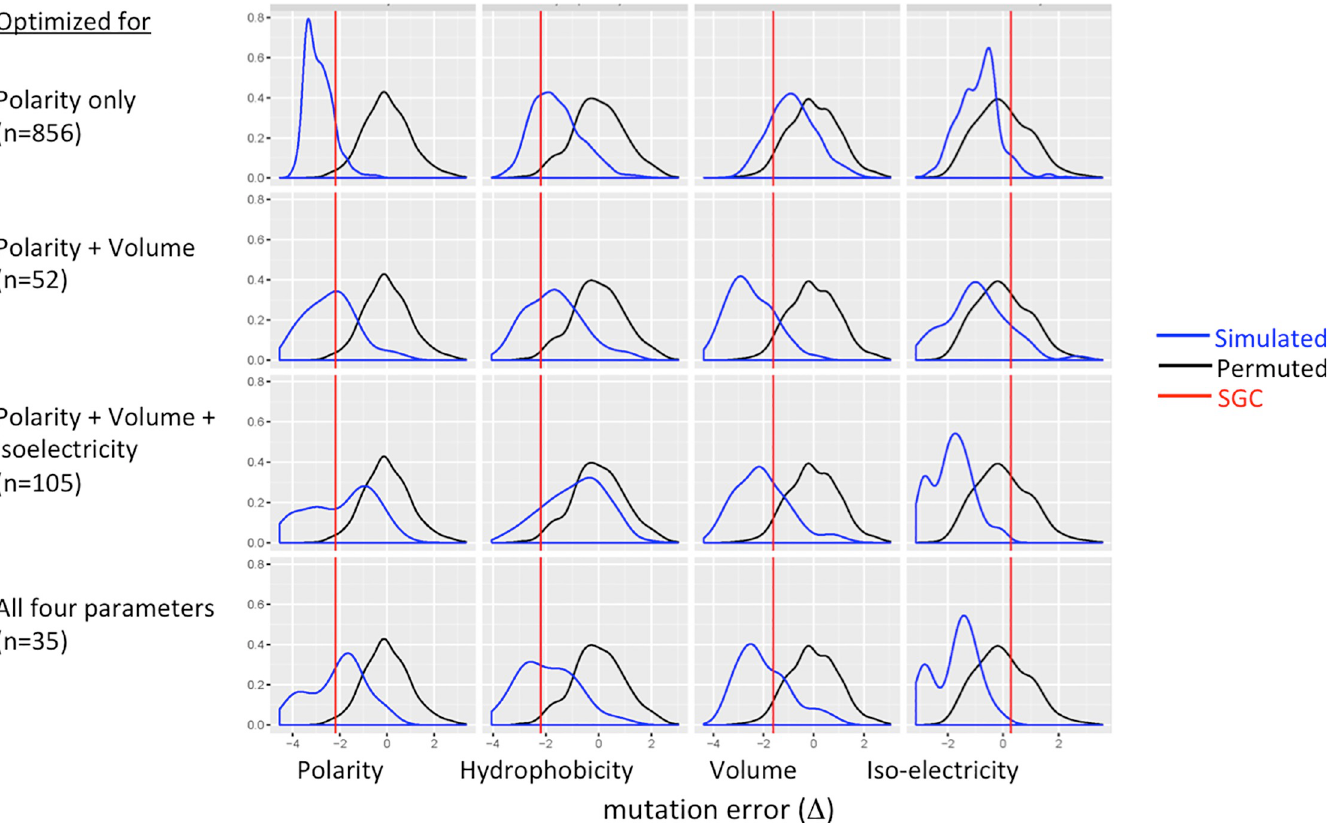
Fig 4. Hopfield network minimizes mutation errors. We constructed a 21-by-21 TSP and searched for the shortest paths traversing the 20 amino acids and the stop codon (21 “cities”) using Hopfield neural networks (see Methods). Distances between the “cities” were determined by either polarity alone ( top row ), or a combination of 2, 3, and all 4 parameters ( other rows ). Valid paths (number in parenthesis) were mapped to the codon wheel resulting in simulated genetic codes. Each simulated code was calculated for average single-mutation error rates based on each parameters (Eq 4). All error rates were normalized according to the mean and standard deviation of random codes (as in Fig 2B) and their distribution were shown as density plots. While it is possible to obtain codes optimized for all four parameters ( bottom row ), the most parsimonious codes with errors similar to SGC errors were generated with the Hopfield network that optimized for polarity alone ( top row ). An alternative way to visualize reduced errors in Hopfield-optimized codes is to show each code as an amino acid tour in a 2-dimensional principal component space, which shows significantly shorter tour lengths of Hopfield-optimized codes than those of permuted code and SGC (Fig 3).